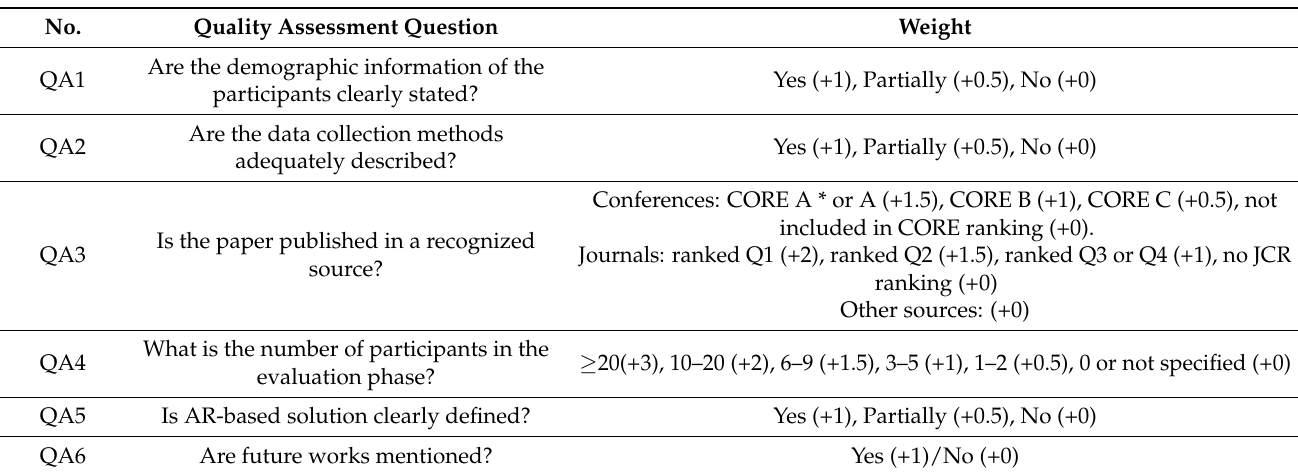
Table 2. Quality assessment criteria.